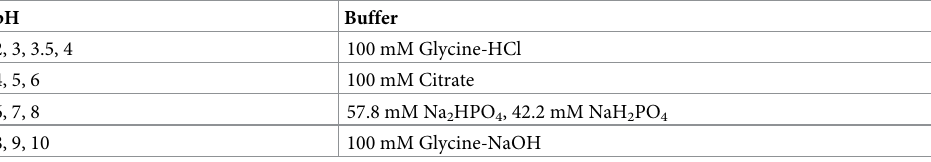
Table 1. Buffers used for determination of pH stability of human